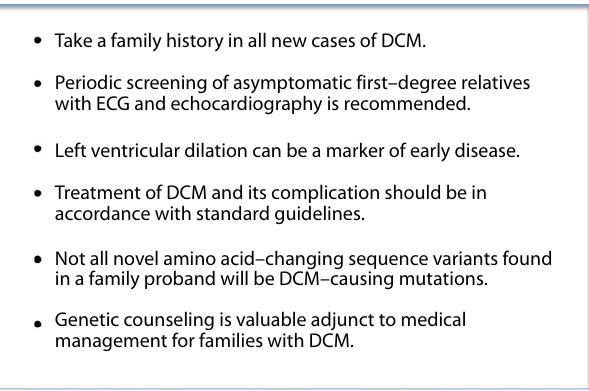
Figure 1. Clinical practice points in familial